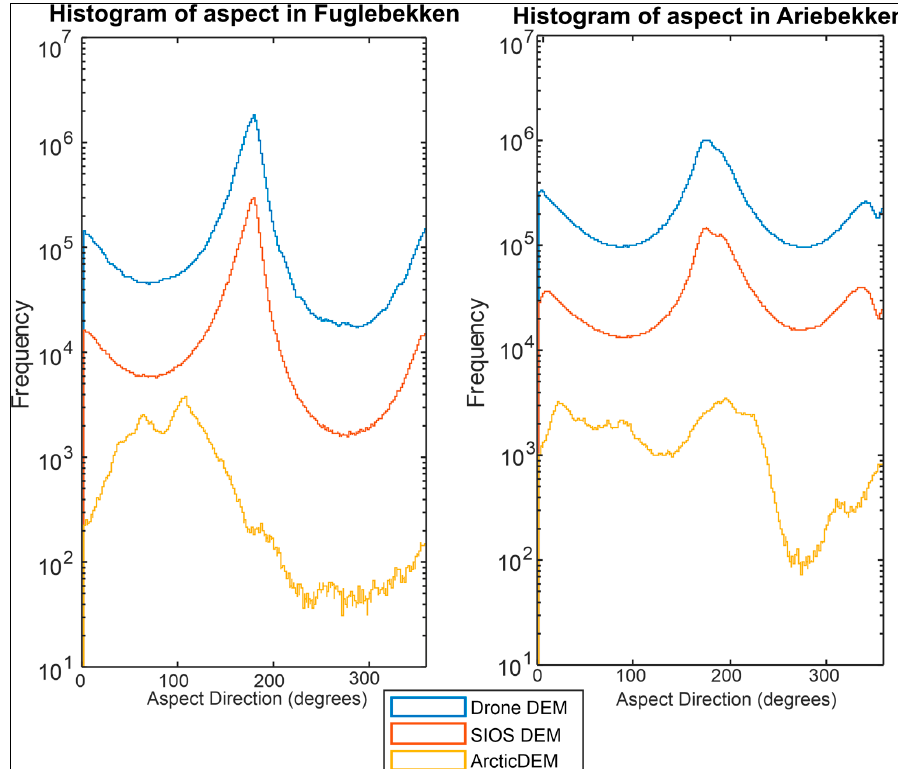
Figure 13. A comparison of aspect histograms of three DEMs in Fuglebekken and Ariebekken catchments. Note the symmetrical form in all three DEMs but the difference in the texture of the